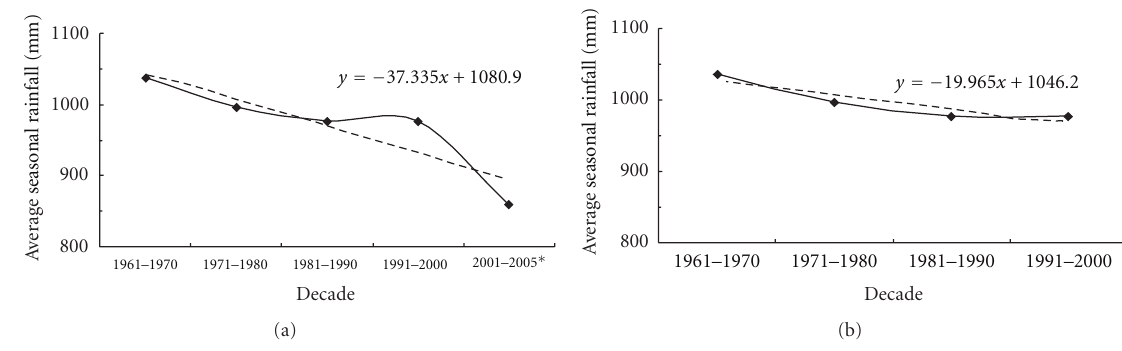
Figure 5: Decadal variation of average seasonal rainfall over the Koyna catchment. Table 2: Average number of rain days ≥ 0.1 mm of rainfall for the stations in the Koyna catchment (1961–2005).